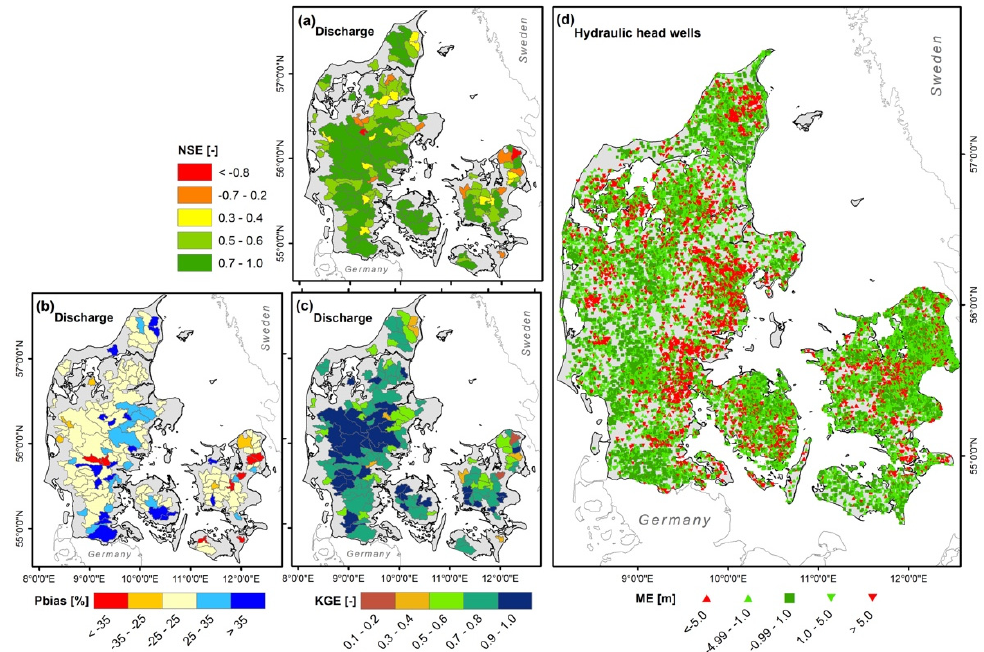
Figure 6. The DK-model performance’s statistical metrics: between the observed and modelled discharge for ( a ) Nash– Sutcliffe efficiency (NSE), ( b ) Pbias, ( c ) Kling-Gupta efficiency (KGE), and between the observed and modelled hydraulic head wells for mean error (ME) ( d ).